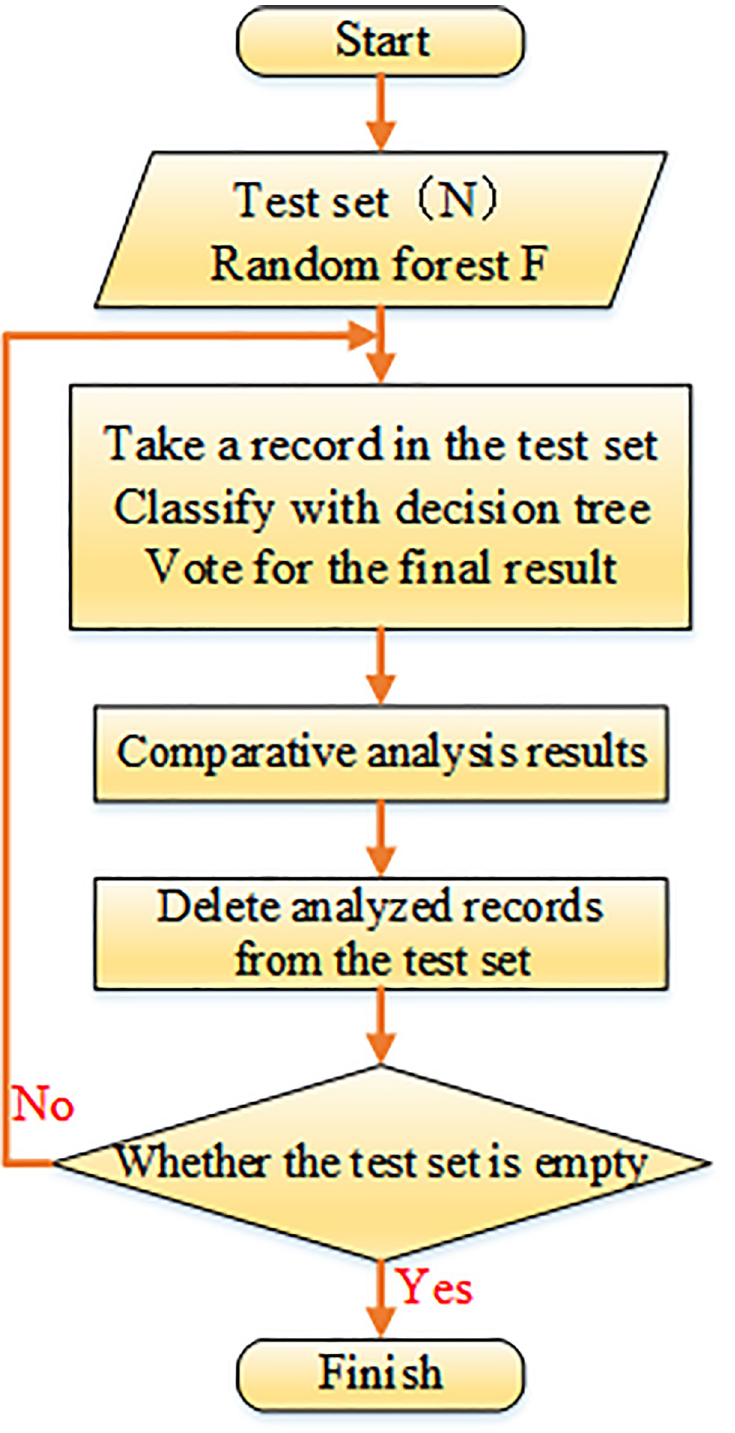
Fig 9. Flow of testing random forest